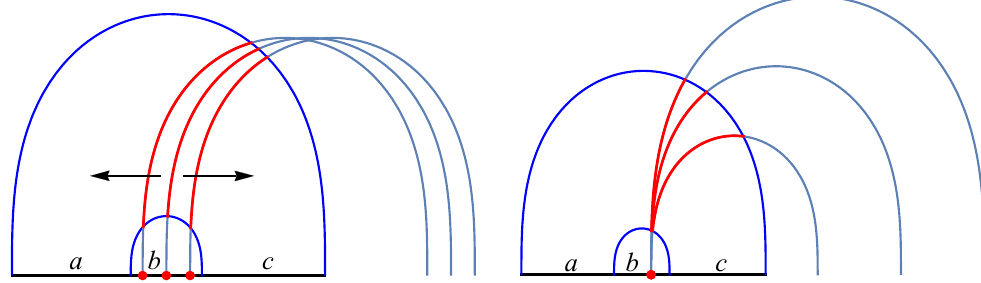
Figure 3 . Left plot: a demonstration of shifting a curve to cut the C b and C a;b;c . The red dots are endpoints. Right plot: a demonstration of solving curves at di(cid:11)erent v = z 0 (0), and use them to cut C b and C a;b;c . The red curves in each plot are the minimal segments connecting each pair of